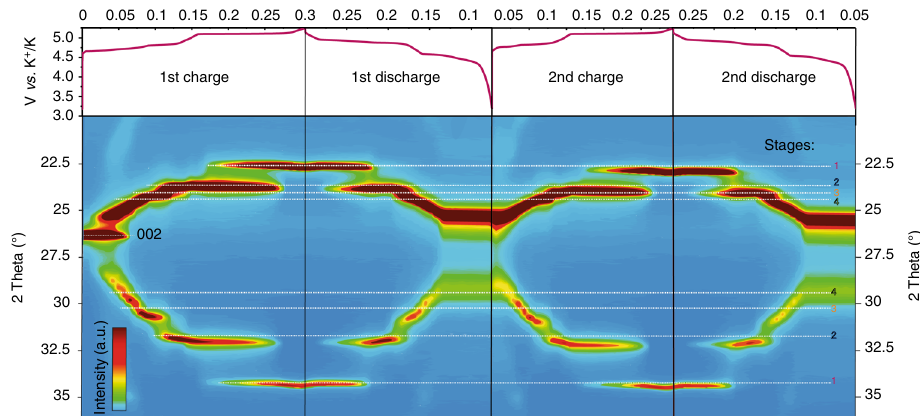
Fig. 3 In situ XRD measurements of graphite during charging and discharging. Top: galvanostatic voltage pro fi le measured at a current density of 10 mA g − 1 for the fi rst two cycles. Bottom: XRD patterns of graphite during cycling. The white horizontal dashed lines correspond to computed positions for different stages (shown in Fig.